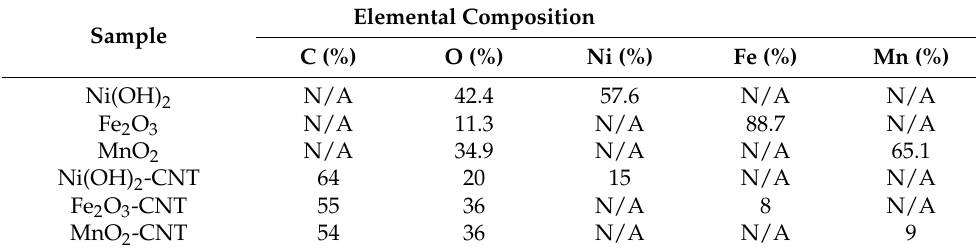
Table 1. Elemental composition of the MOs and MO-CNT hybrids.